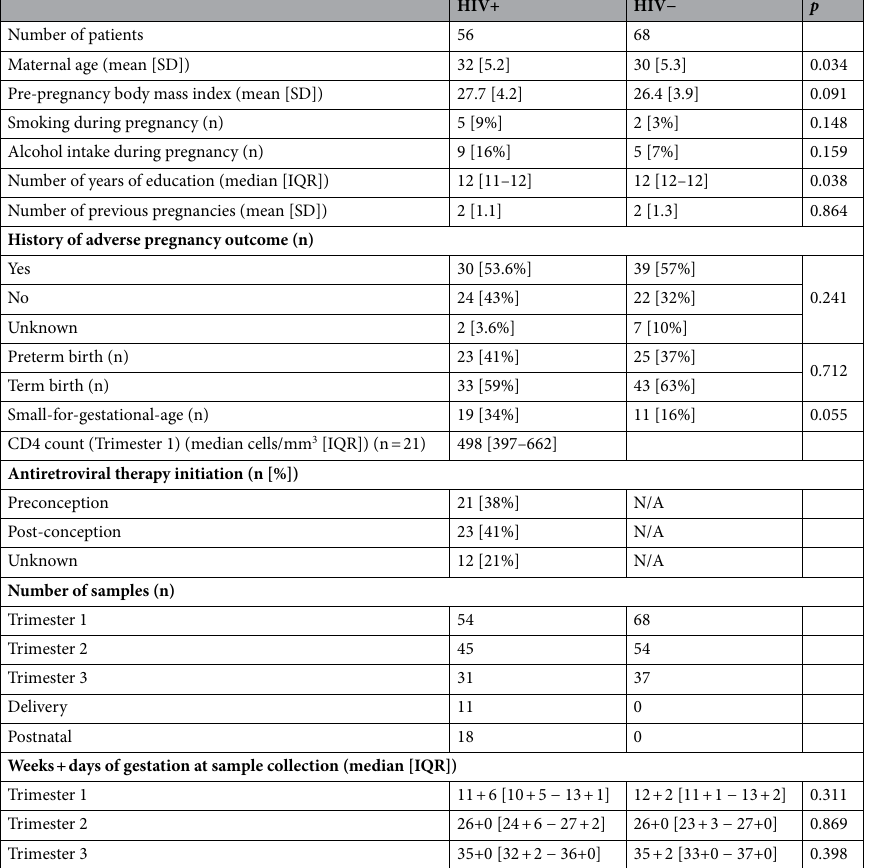
Table 1. Patient characteristics. Characteristics of pregnant women living with HIV (HIV+) and pregnant HIV-negative women (HIV−) enrolled in prospective pregnancy cohort study in Soweto, South Africa, of whom plasma samples were analysed. Statistical comparisons were made using unpaired t test, Mann–Whitney U test, Chi-square test or Fisher’s exact test, as appropriate. History of adverse pregnancy outcome: at least one occurrence of preterm birth, low birth weight, miscarriage, stillbirth or neonatal